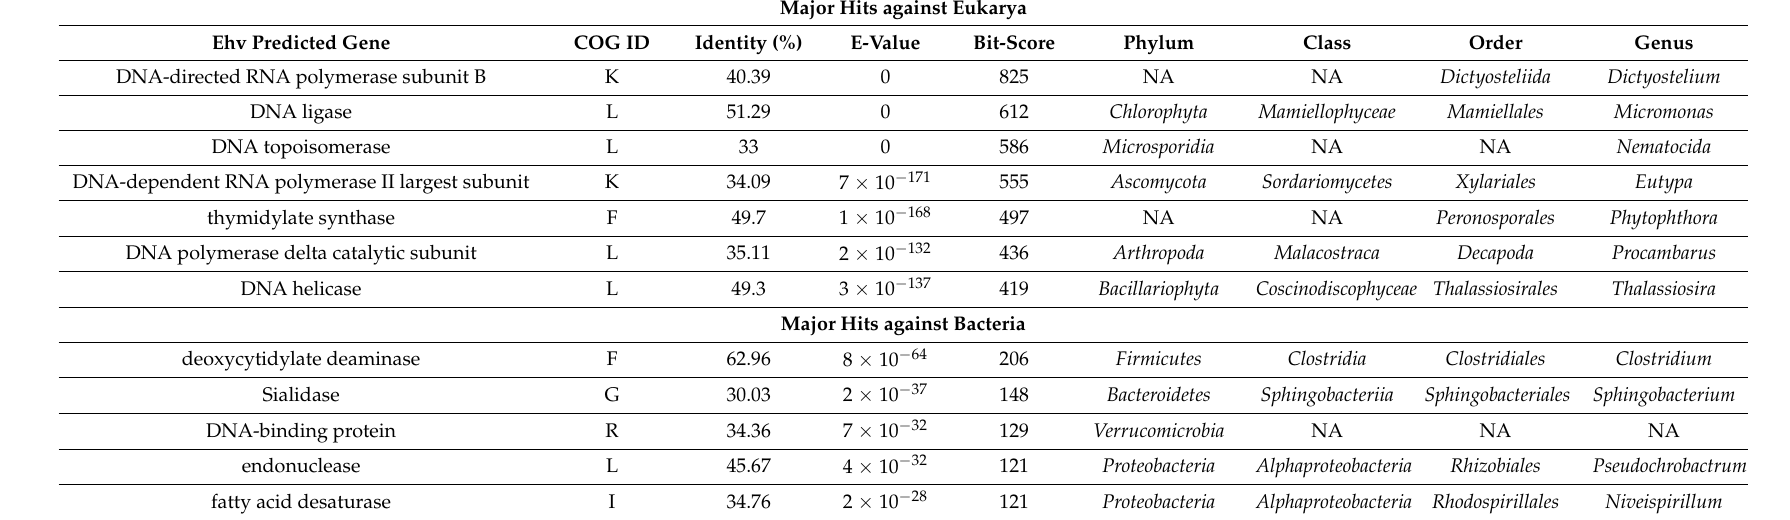
Table 6. “Best BLAST hit” analysis of EhVs against the Bacterial and Eukaryotic domains of life, as well as against the known host Emiliania huxleyi . The top EhV genes with function predictions are shown based on the “Best BLAST hit” analysis using a BitScore of >100 and are ordered based on their E-value. The COG (Clusters of Orthologous Groups of genes with similar functions across the domains of life) cluster for each gene was identified on IMG/ER, where the different letters represent metabolic pathways involved in nucleotide transport and metabolism [F]; carbohydrate transport and metabolism [G]; general function prediction only [R]; replication, recombination and repair [L]; lipid transport and metabolism [I]; transcription [K]; inorganic ion transport and metabolism [P]; intracellular trafficking, and secretion and vesicular transport